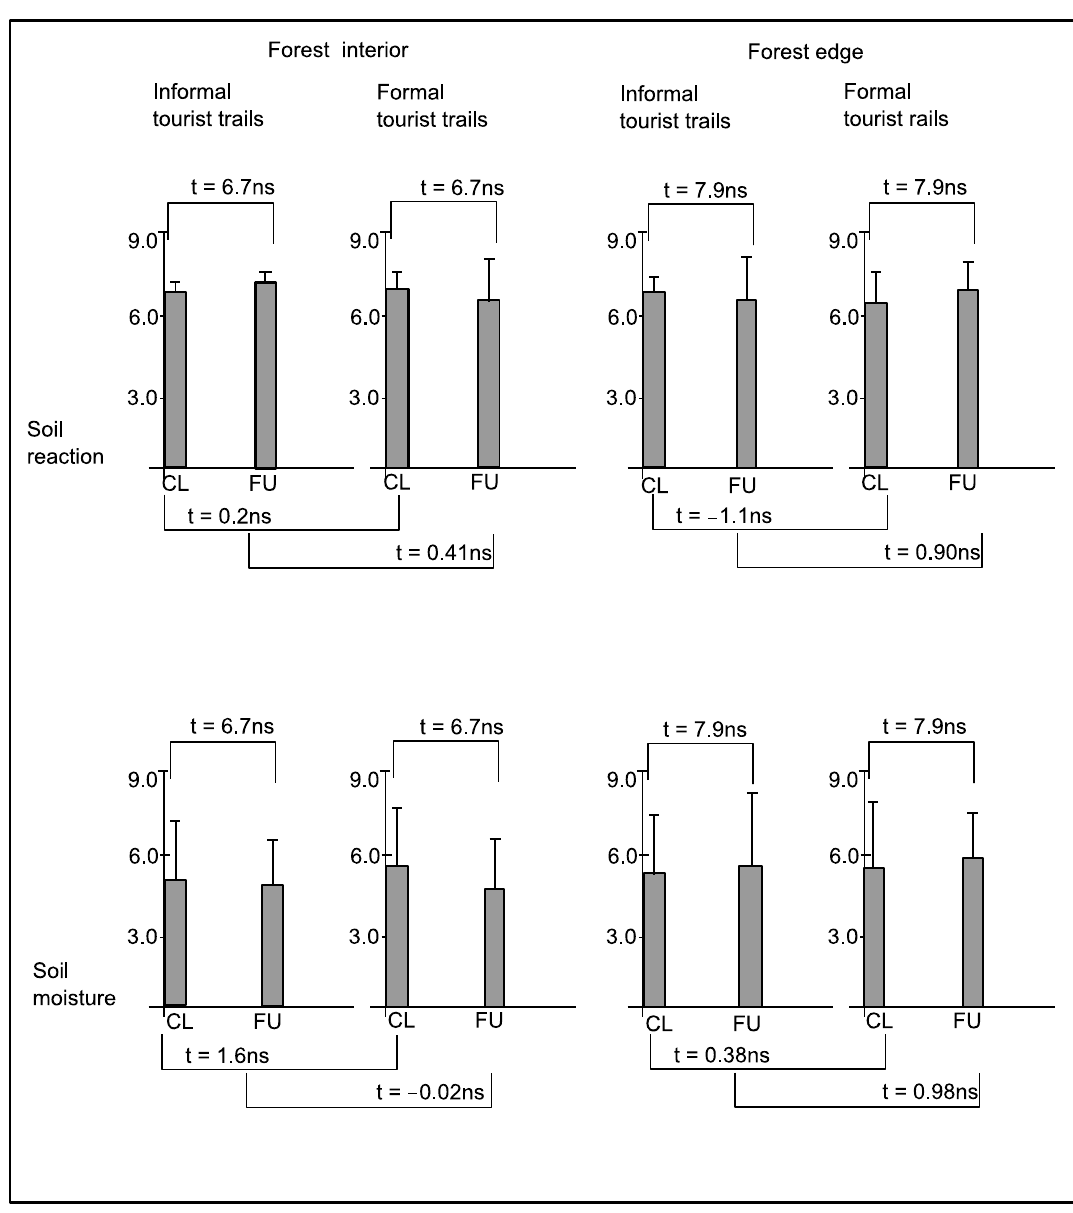
Figure 3. The mean values of soil reaction (±SD) and soil moisture (±SD) in closer (CL) and further (FU) plots located along informal (width < 50 cm) and formal (width > 150 cm) tourist trails within the forest interior and forest edge sites. The statistical significance level is explained in Figure 2.